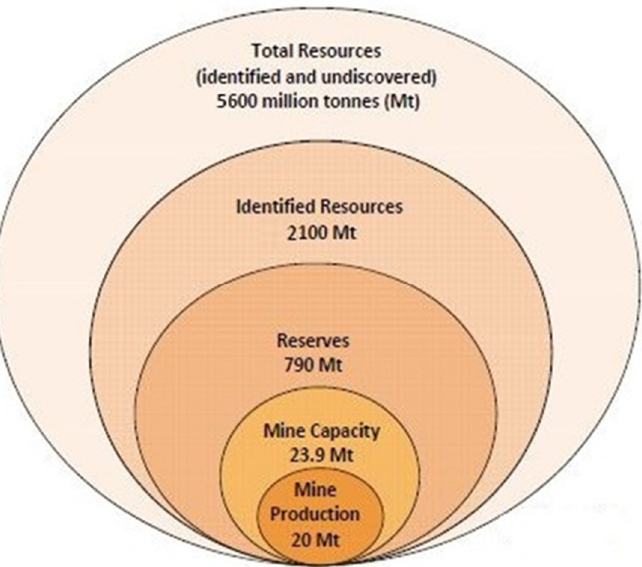
Figure 4. World copper reserve and mine production [31].